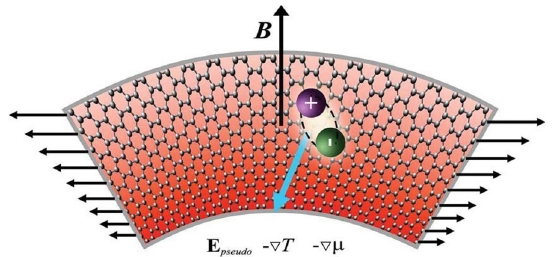
Figure 3. Conceptual picture of the quantum Hall effect of PMEs in graphene. The QHE PME flow, shown by the blue arrow, is generated by the PMF B , normal to the graphene layer, and a pseudoelectric field E pseudo or T , or µ , directed along the graphene layer. The QHE PME flow in the graphene layer is directed normal −∇ −∇ T , or µ . The strain is created by the normal forces applied at two opposite boundaries and to E pseudo or −∇ −∇ their magnitude is gradually decreased, which is indicated by the length of the plotted